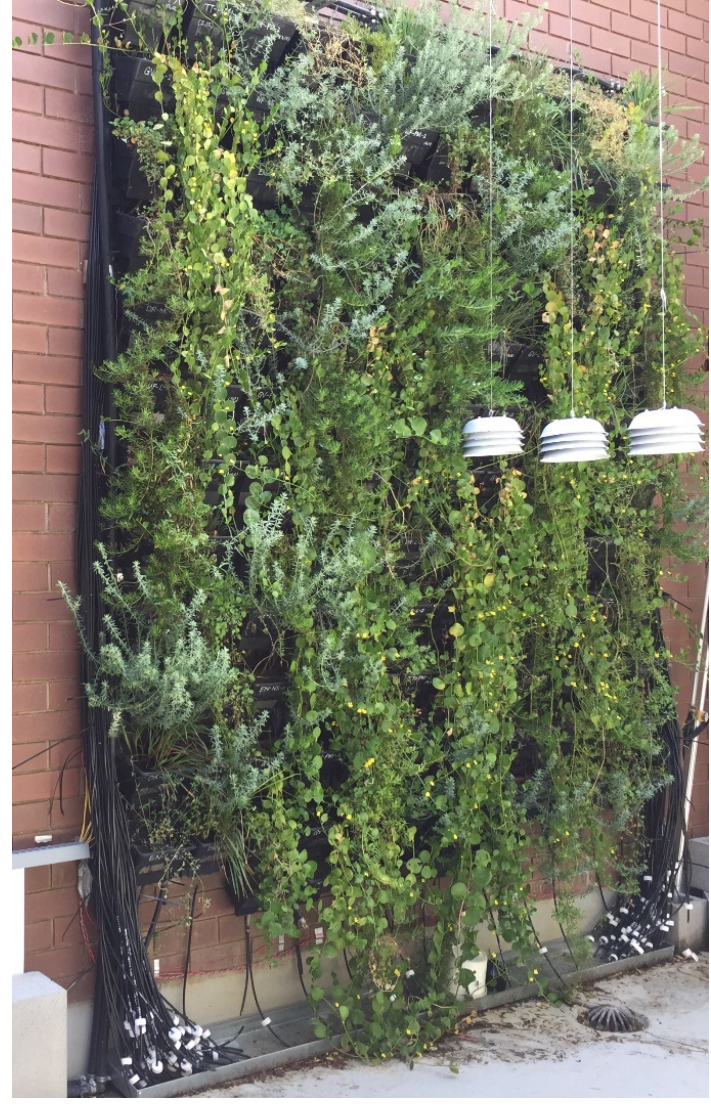
Figure 2. Experimental Living Wall. Table 1. Plant–substrate–irrigation arrangement on the living